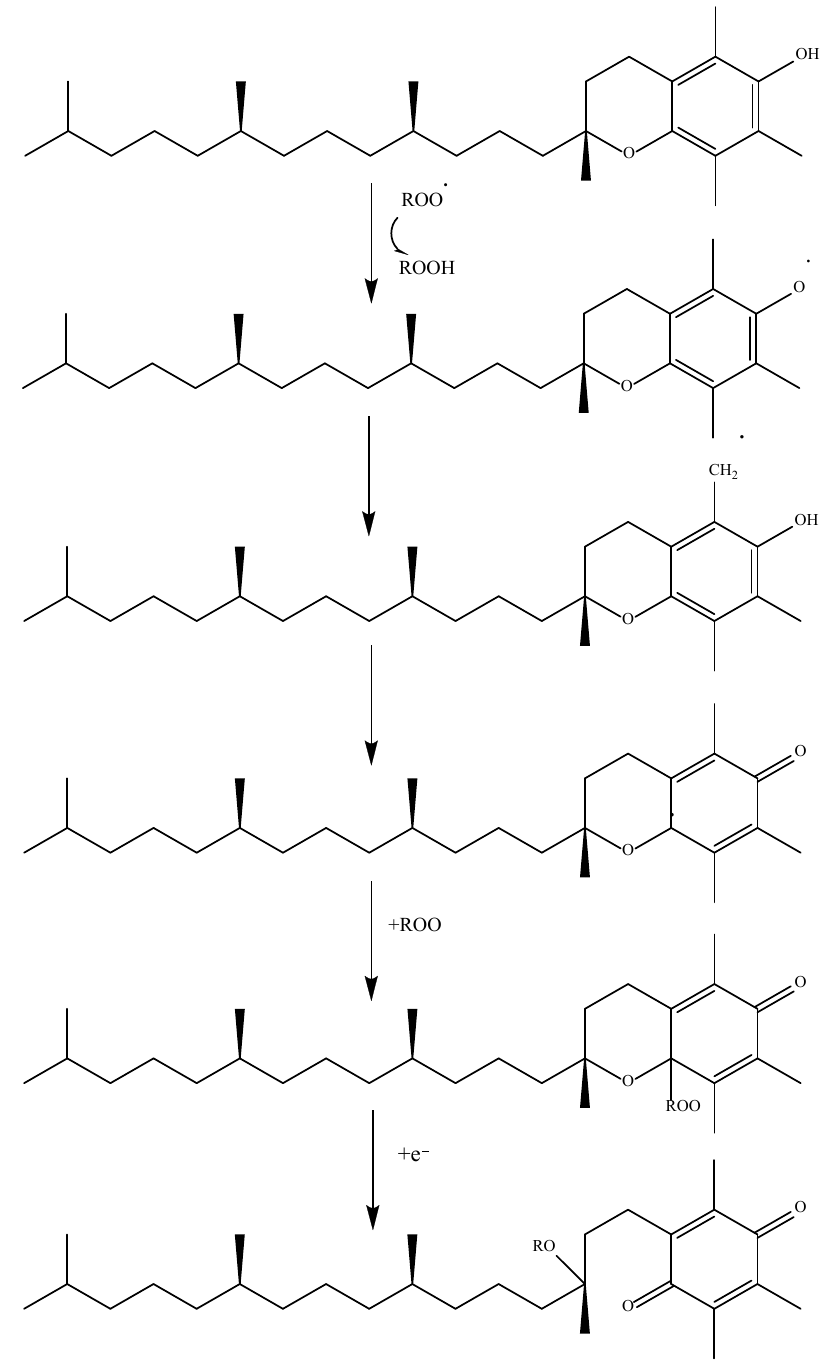
Figure 7. α -Tocopherol neutralizing a free radical via SPLET [46,49].